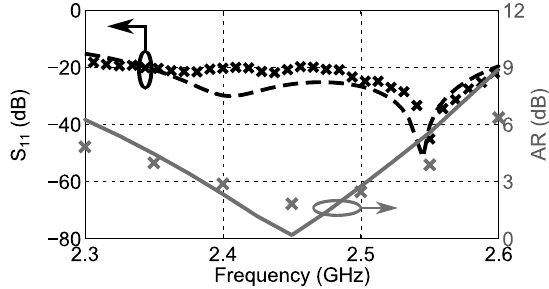
FIGURE 16. Measured impedance matching and broadside AR performance of the CP Half E-shaped patch antenna prototype shown in Fig. 14. Measurements and simulations shown with × markers and solid lines, respectively. Adapted from